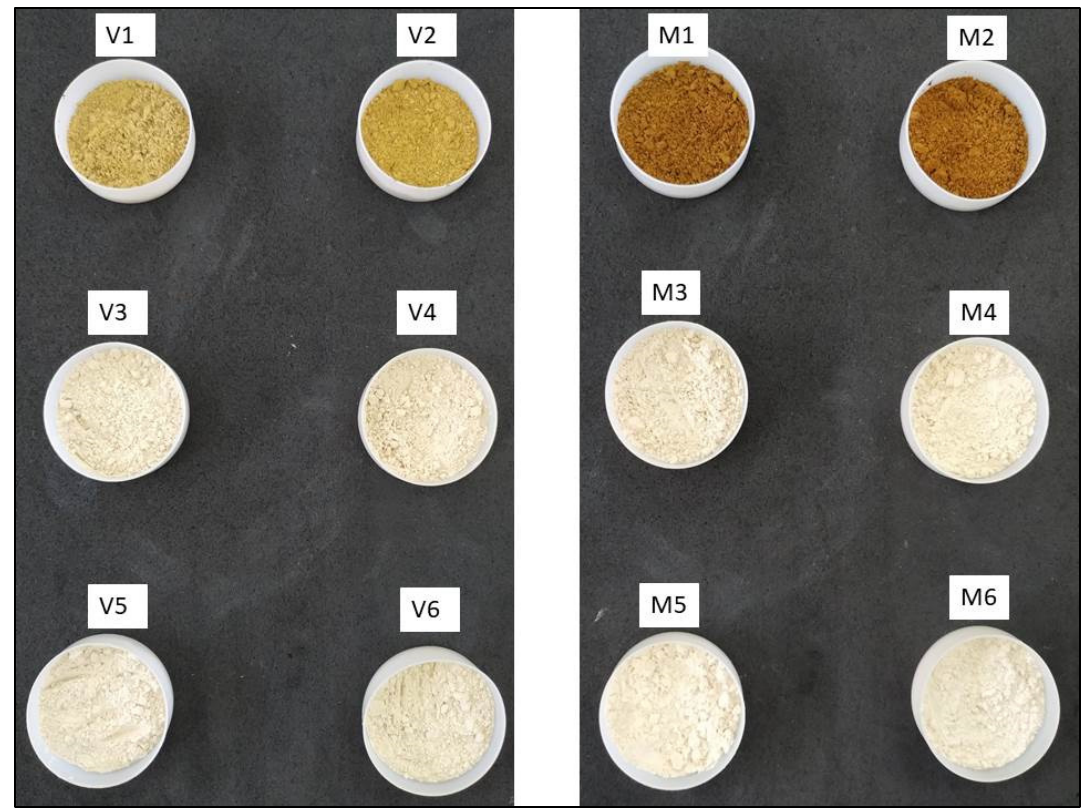
Figure 1. Appearance of powders obtained by spray drying of papaya seed extracts. In this figure, V1: unripe seed extract with 0% maltodextrin and dried at 130 °C; V2: unripe seed extract with 0% maltodextrin and dried at 150 °C; V3: unripe seed extract with 15% maltodextrin and dried at 130